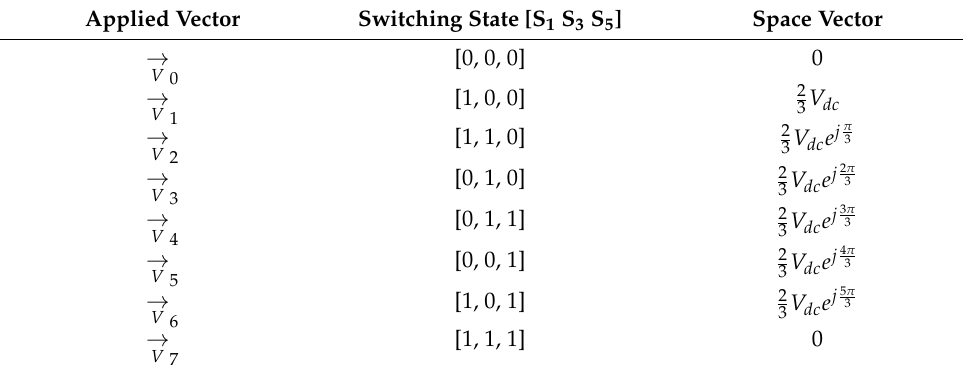
Table 1. Possible switching states for the two-level VSI and space vectors generated. Applied Vector